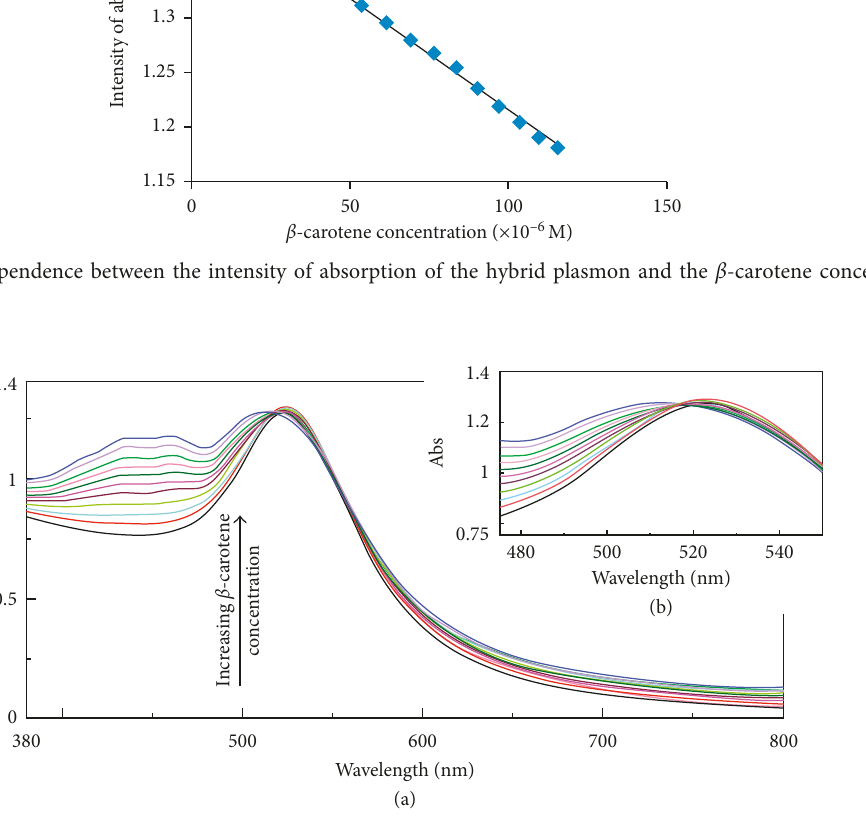
Figure 5: Overlapped UV-Vis spectra for adding β -carotene solution to gold colloid solution (a). Details of the isosbestic point at 515nm (b).